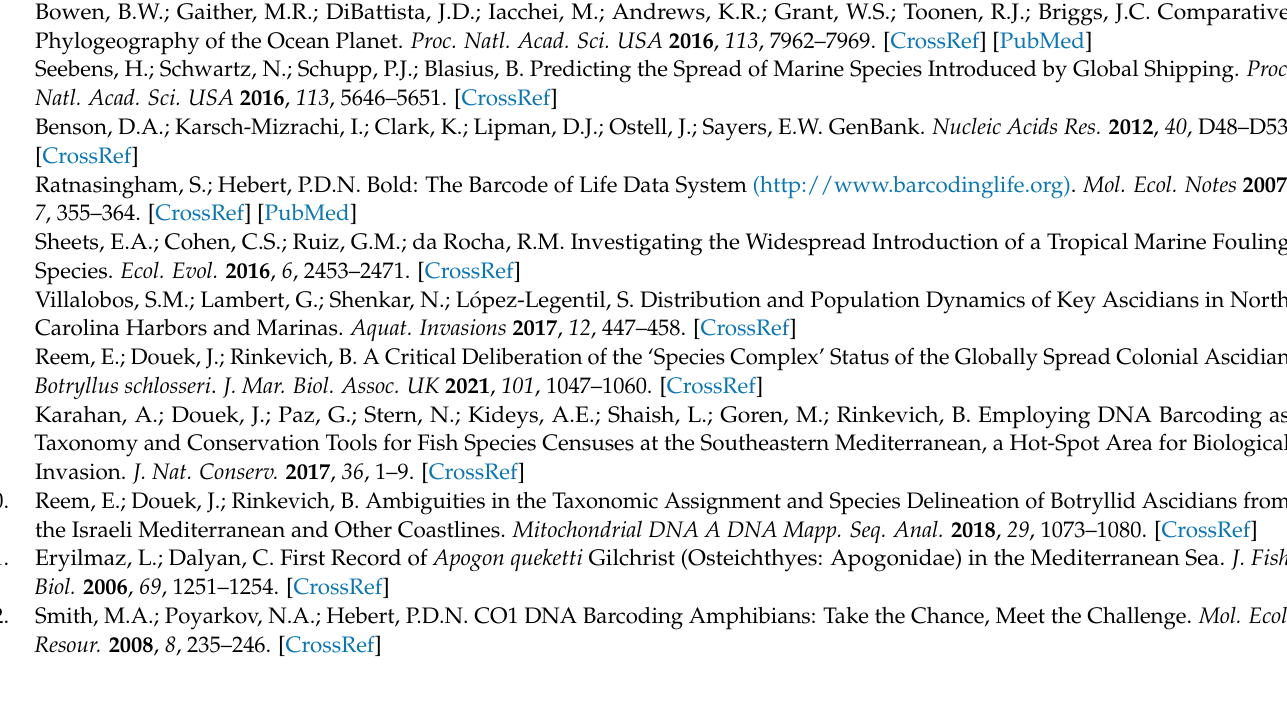
Table S9: Correspondence between sample IDs, morphotypes and the determined haplotypes and genotypes for COI, H3, 18S and